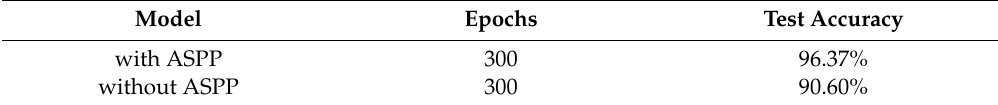
Table 3. Model comparison with or without the ASPP module.